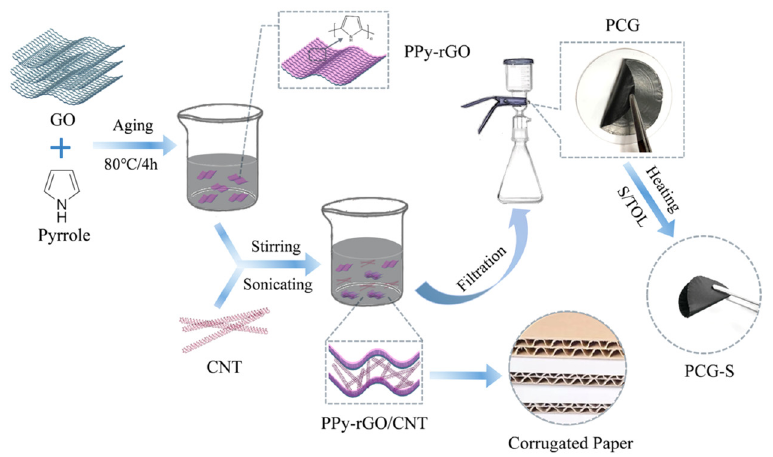
Figure 14. Schematic diagram of the synthesis process and structure of PCG-S paper. Reprinted with permission from reference [38]. Copyright (2020) American Chemical Society.